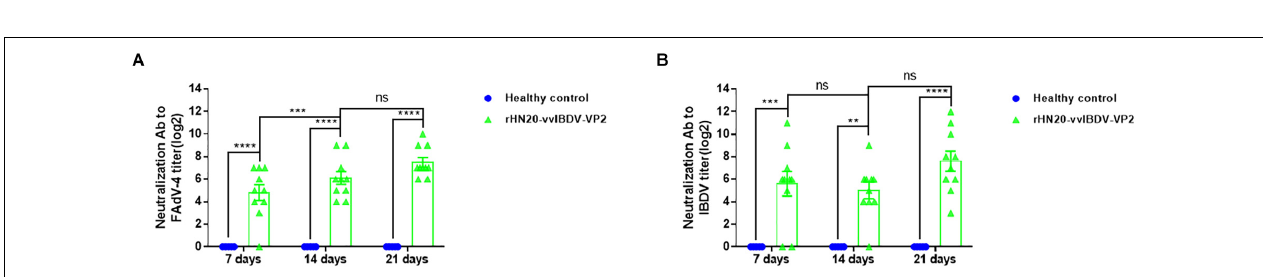
FIGURE 6 | Construction of rHN20-vvIBDV-VP2 recombinant virus. (A) Diagram of rHN20-vvIBDV-VP2. (B) PCR identification of rHN20-vvIBDV-VP2. (C) Indirect immunofluorescence (IFA) identification of rHN20-vvIBDV-VP2 with monoclonal anti-IBDV-VP2. (D) Replication kinetics of rHN20 and rHN20-vvIBDV-VP2.